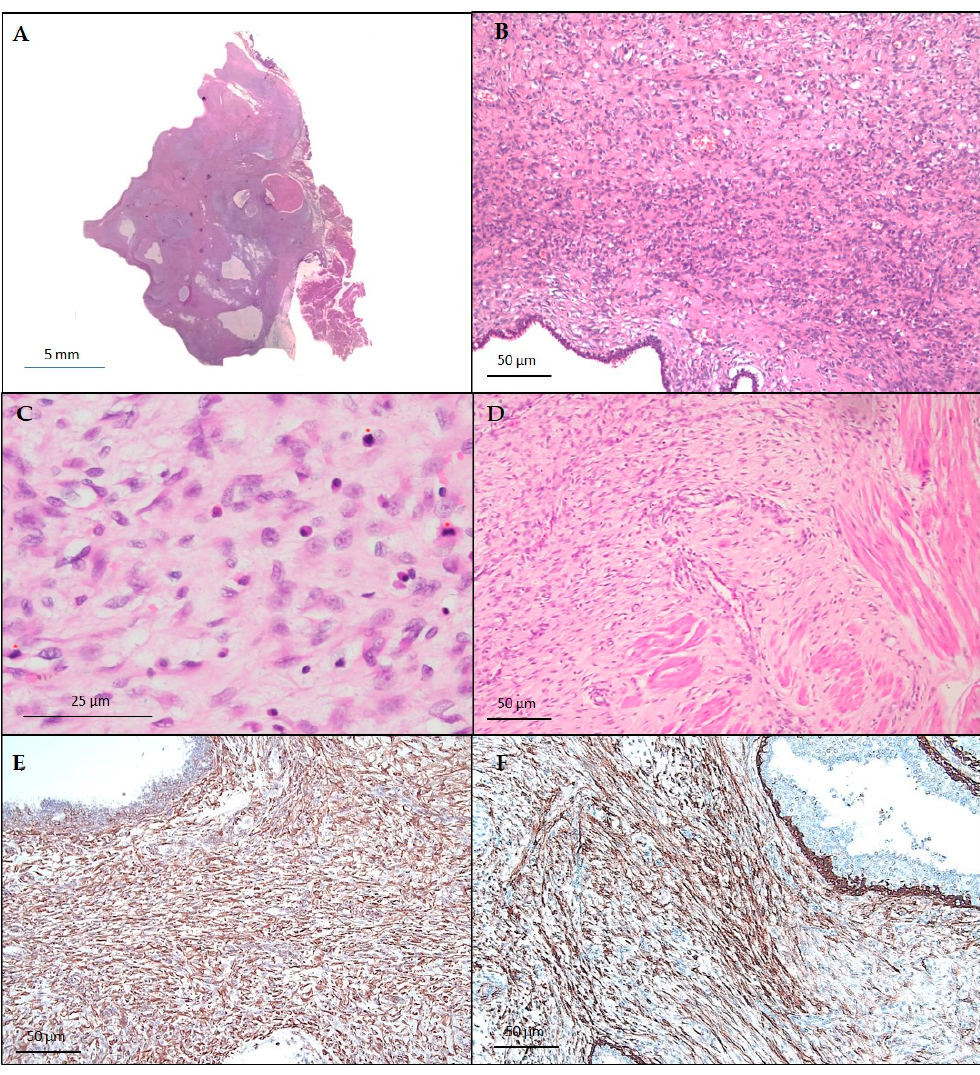
Figure 3. Malignant PT, showing marked and diffuse stromal cellularity and overgrowth ( A ) hematoxylin and eosin, panoramic view; ( B ) hematoxylin and eosin, original magnification × 100, pleomorphic stromal cells with brisk mitotic activity ( C ) hematoxylin and eosin, original magnification × 400, and permeative margins ( D ) hematoxylin and eosin, original magnification × 200. Immunohistochemical staining was positive for vimentin ( E ) original magnification × 100 and CD10 ( F ) original magnification × 100 in stromal cells.